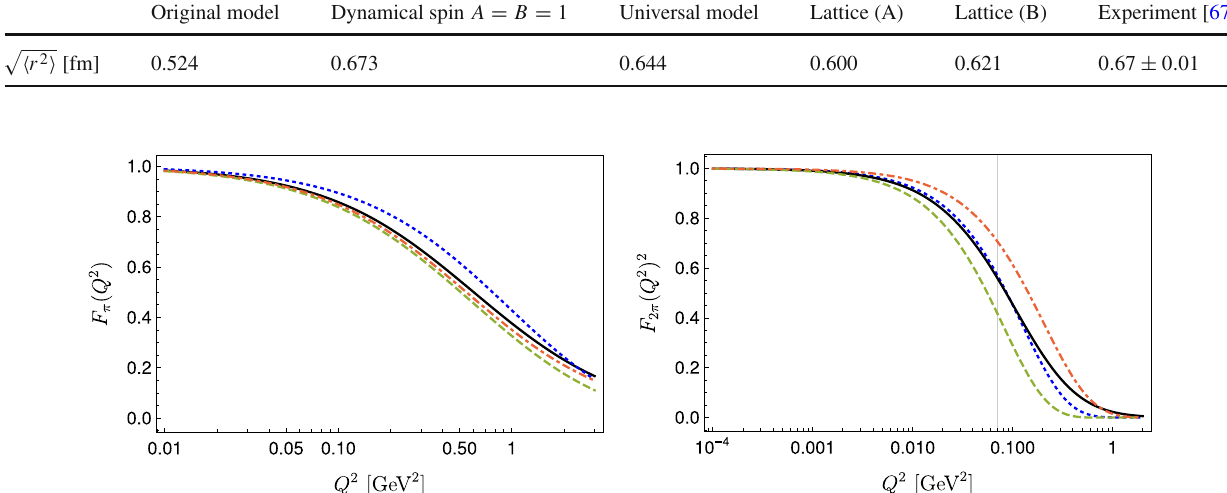
Fig. 6 Left panel: the pion form factor evaluated within the lattice framework (full black line), the original model (dotted blue line), the dynamical spin model (dashed green line), in the A = B = 1 configu-